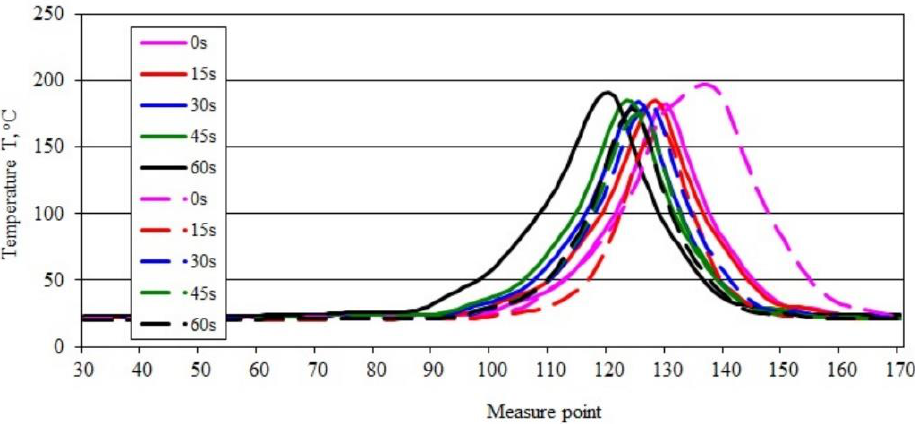
Figure 9. Temperature along the burning PE and PBS sample recorded in area 2 (description in the text). For both the tested materials with 50% filler content, the results were different from those obtained for unfilled materials (Figure 10). The curves of temperature change over time for PE50 testify to a gradual decrease in the intensity of the combustion process, which is also indicated by a decrease in the maximum flame temperature at the sample axis. The curves obtained for PBS50, on the other hand, show a steady increase in the maximum temperature in the longitudinal axis of the samples, indicating flame propagation.